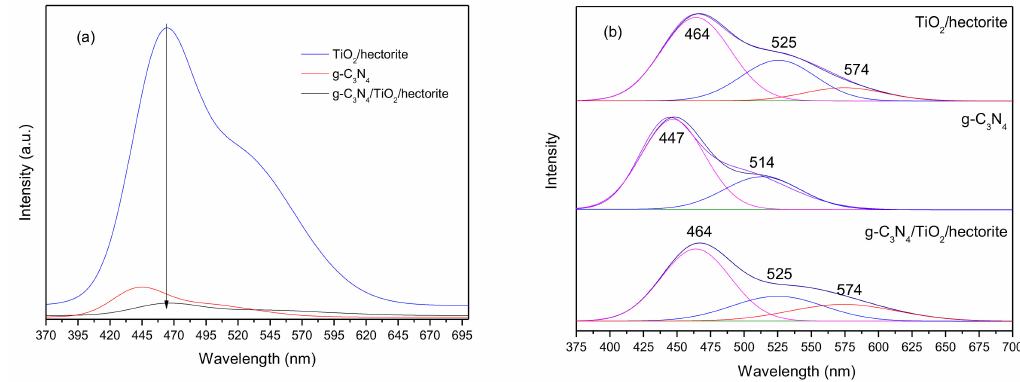
Figure 5. ( a ) Photoluminescence (PL) spectra and ( b ) Gaussian function fitted graphs (R 2 = 0.996) for TiO 2 / hectorite, g-C 3 N 4 and g-C 3 N 4 // TiO 2 /